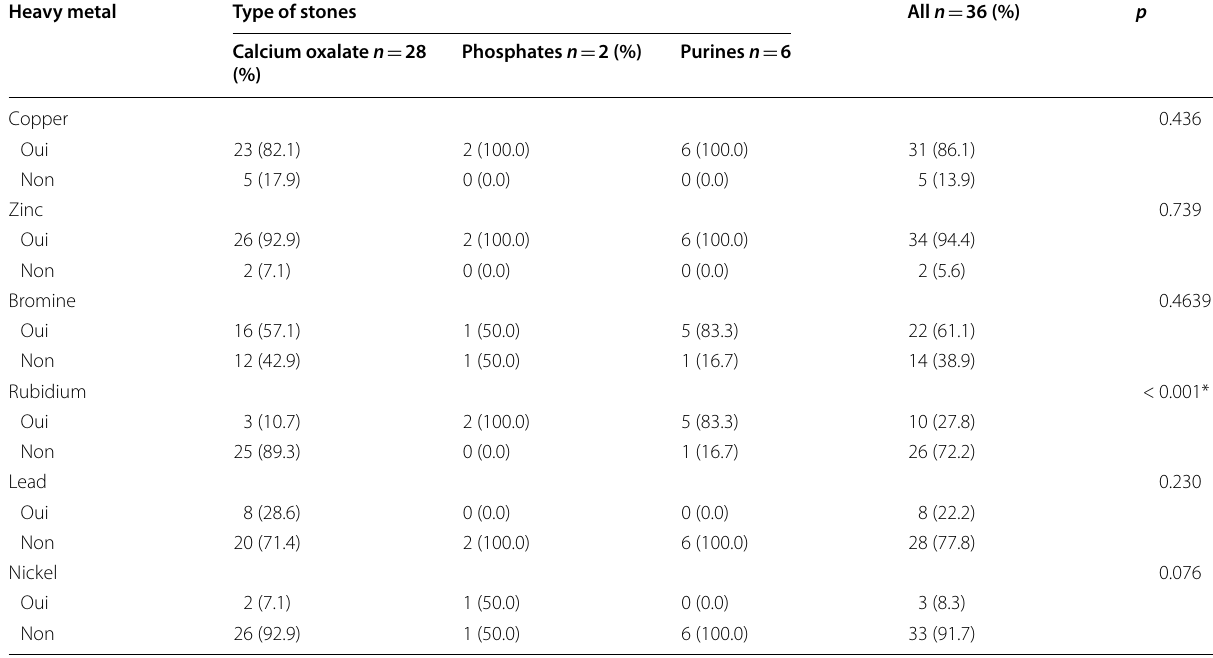
Table 4 Distribution of heavy metals according to the main components of stones grouped together